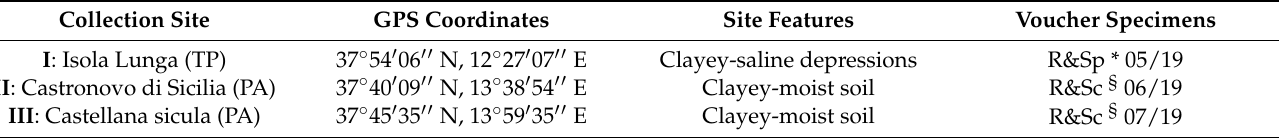
Table 4. Details of M. pulegium leaf (MPL) and flower (MPF)